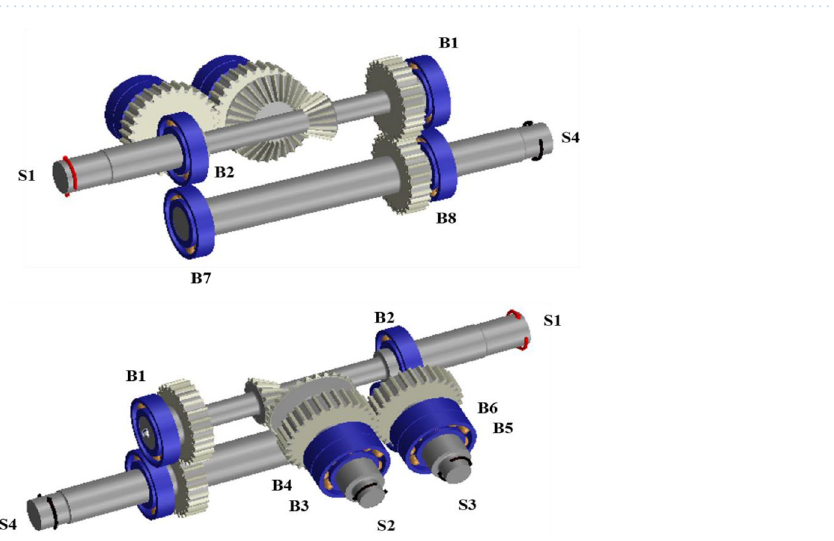
Figure 2. Configuration of power transmission system for maize harvester 15 .